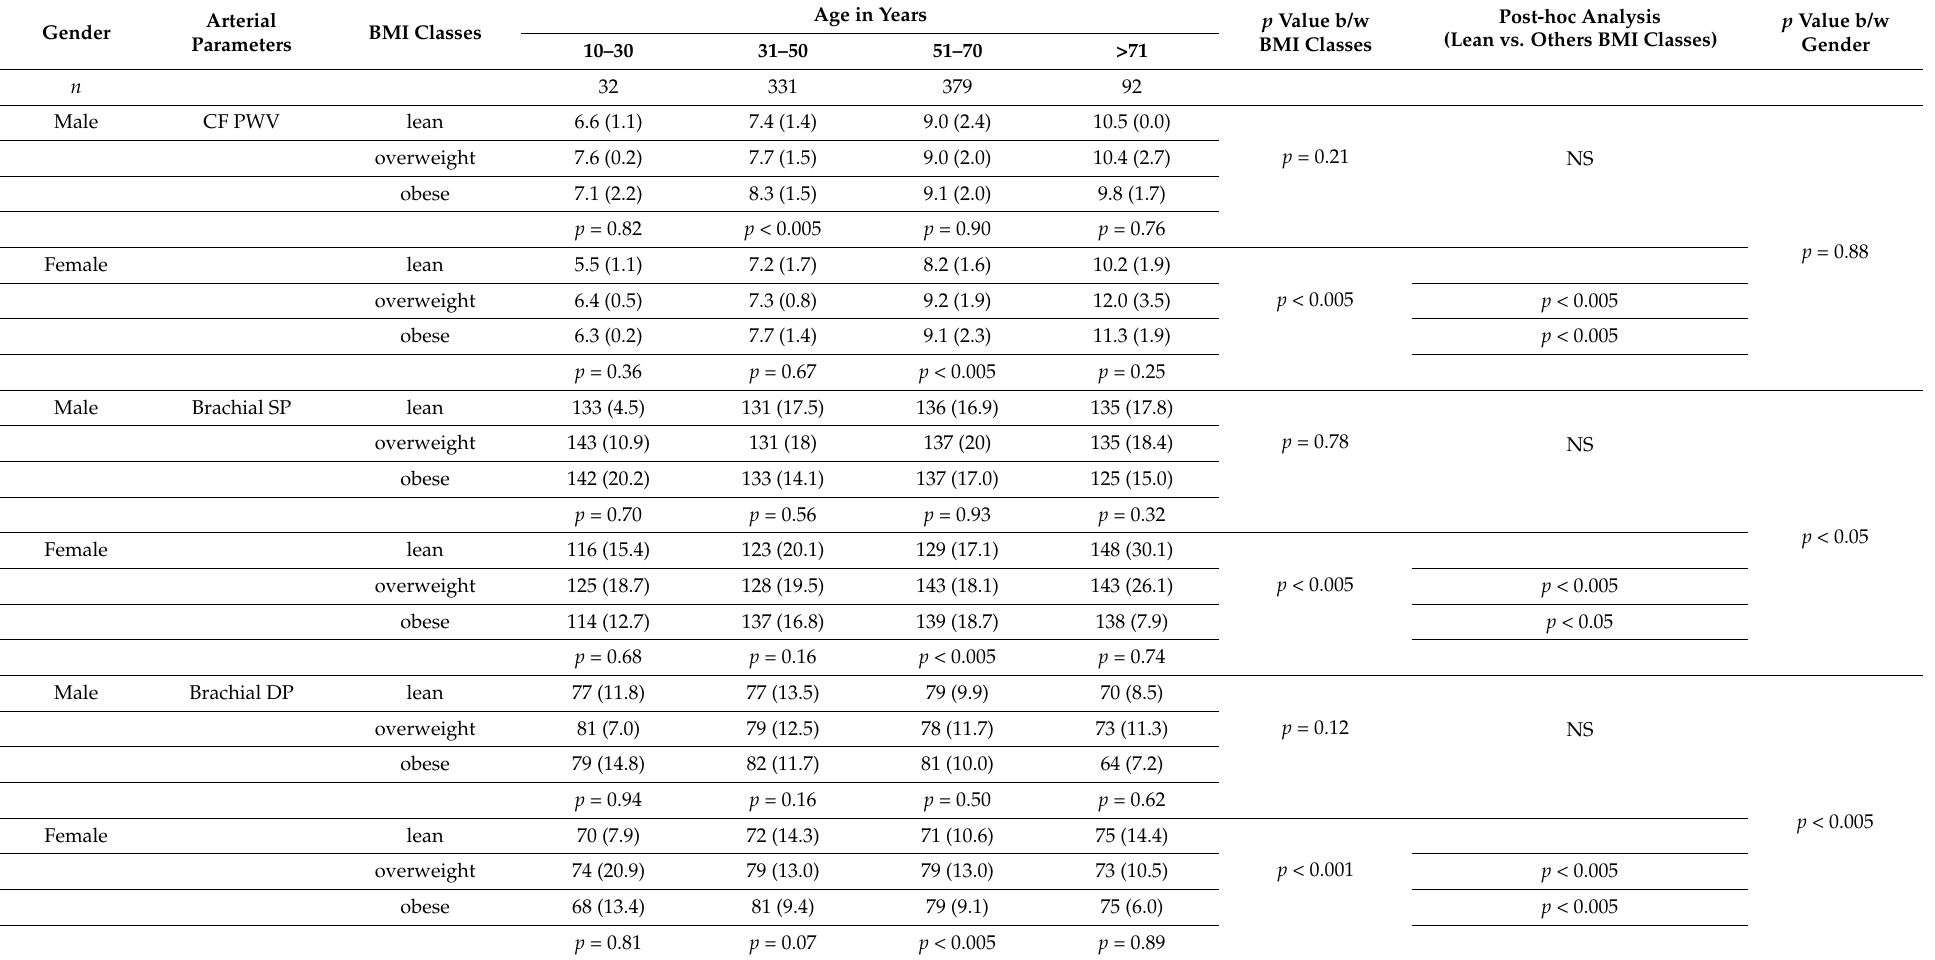
Table 2. Arterial parameters (mean ± SD) grouped by age and sex (males and